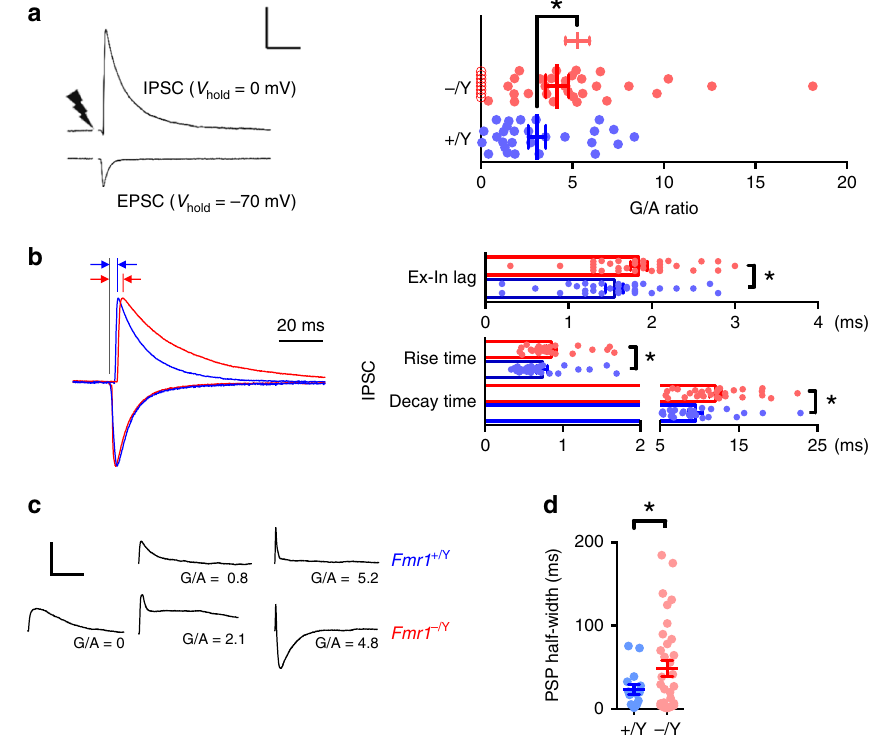
Fig. 3 Altered thalamocortical FFI in P10 – 11 Fmr1-KO mouse. a Left: Trial-averaged voltage-clamp recordings showing direct thalamocortical EPSCs and FF-IPSCs from an example Fmr1 + /Y Layer 4 SC, Scale: 25 ms/500pA. The strength of TC-FFI ( “ G/A ratio ” ) is quanti fi ed as the ratio of peak evoked current. Right: Strength of TC-FFI at P10 – 11. Points indicate neurons, bars are mean ± SEM. Unlike for Fmr1 + /Y recordings (28 neurons, max. 3 per animal), in Fmr1 − /Y neurons, some cells (8/38 neurons, max. 3 per animal) lacked FFI; light red bars indicate FFI strength of cells with G/A > 0, hollow markers. Including Fmr1 − /Y neurons with G/A = 0, average strength of FFI was not signi fi cantly different to that of Fmr1 + /Y , but excluding these neurons (dark red bars and solid markers), the average strength was elevated over that of FFI in wild-type recordings ( Fmr1 + /Y vs. all Fmr1 − /Y neurons: p = 0.40, Fmr1 + /Y vs. Fmr1 − /Y neurons with G/A > 0: p = 0.005, Mann – Whitney). b Synaptic kinetics of currents underlying TC-FFI. Left: Example TC-evoked currents in from Fmr1 + /Y (blue) and Fmr1 − /Y (red), EPSCs and FF-IPSCs, individually scaled to peak amplitudes. Note the slower decay time constant and onset latency for Fmr1 − /Y FFI-PSCs (indicated by red and blue arrows). Right: Slower FFI synaptic kinetics for Fmr1 − /Y SCs. No signi fi cant genotype-dependent differences were observed in the same comparisons for kinetics of EPSCs. Asterisks indicate p < 0.05 ( t -test), N ’ s (neurons): 23 Fmr1 + /Y /26 Fmr1 − /Y (EPSCs); 27 Fmr1 + /Y /28 Fmr1 − /Y (FF-IPSCs). c Example TC EPSPs from SCs receiving low, medium and high TC-FFI. Note the progressive curtailment of EPSP duration with increasing FFI strength, the lack of a Fmr1 + /Y example for G/A = 0, and the exaggerated IPSP for the high strength FFI Fmr1 − /Y example. d Slower TC EPSPs in Fmr1 − /Y . Full width at half-height ( ‘ half-width ’ ) of EPSPs from SCs ( N (neurons) = 19 Fmr1 + /Y , 36 Fmr1 − /Y ), bars are mean ± SEM, asterisks denote p < 0.05 ( t -test). Not shown: the dependence of Fmr1-KO thalamocortical EPSP duration on the strength of FFI is distorted. Fmr1-KO Neurons with weaker/no FFI (G/A ratio < 2) showed speci fi cally broadened EPSP duration (22.4 ± 7.30 ms vs. 68.4 ± 16 ms, Fmr1 + /Y vs. Fmr1 − /Y , p = 0.02), whereas this effect was dampened in neurons with stronger FFI (13.2 ± 8.70 ms vs. 37.1 ± 15.8 ms, Fmr1 + /Y vs. Fmr1 − /Y , p =